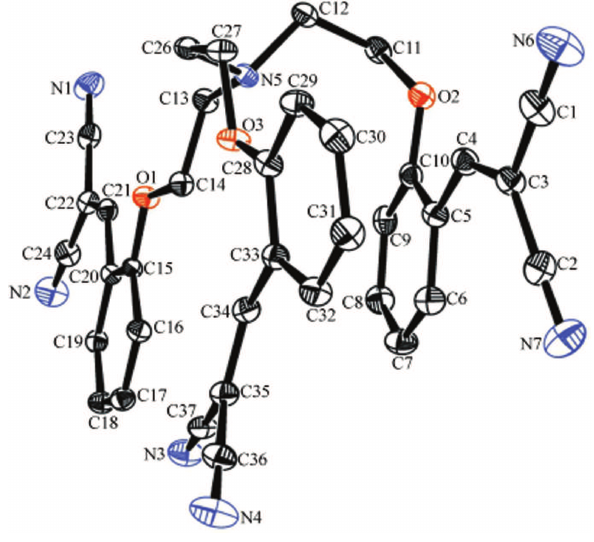
Table 1: Data collection and handling.